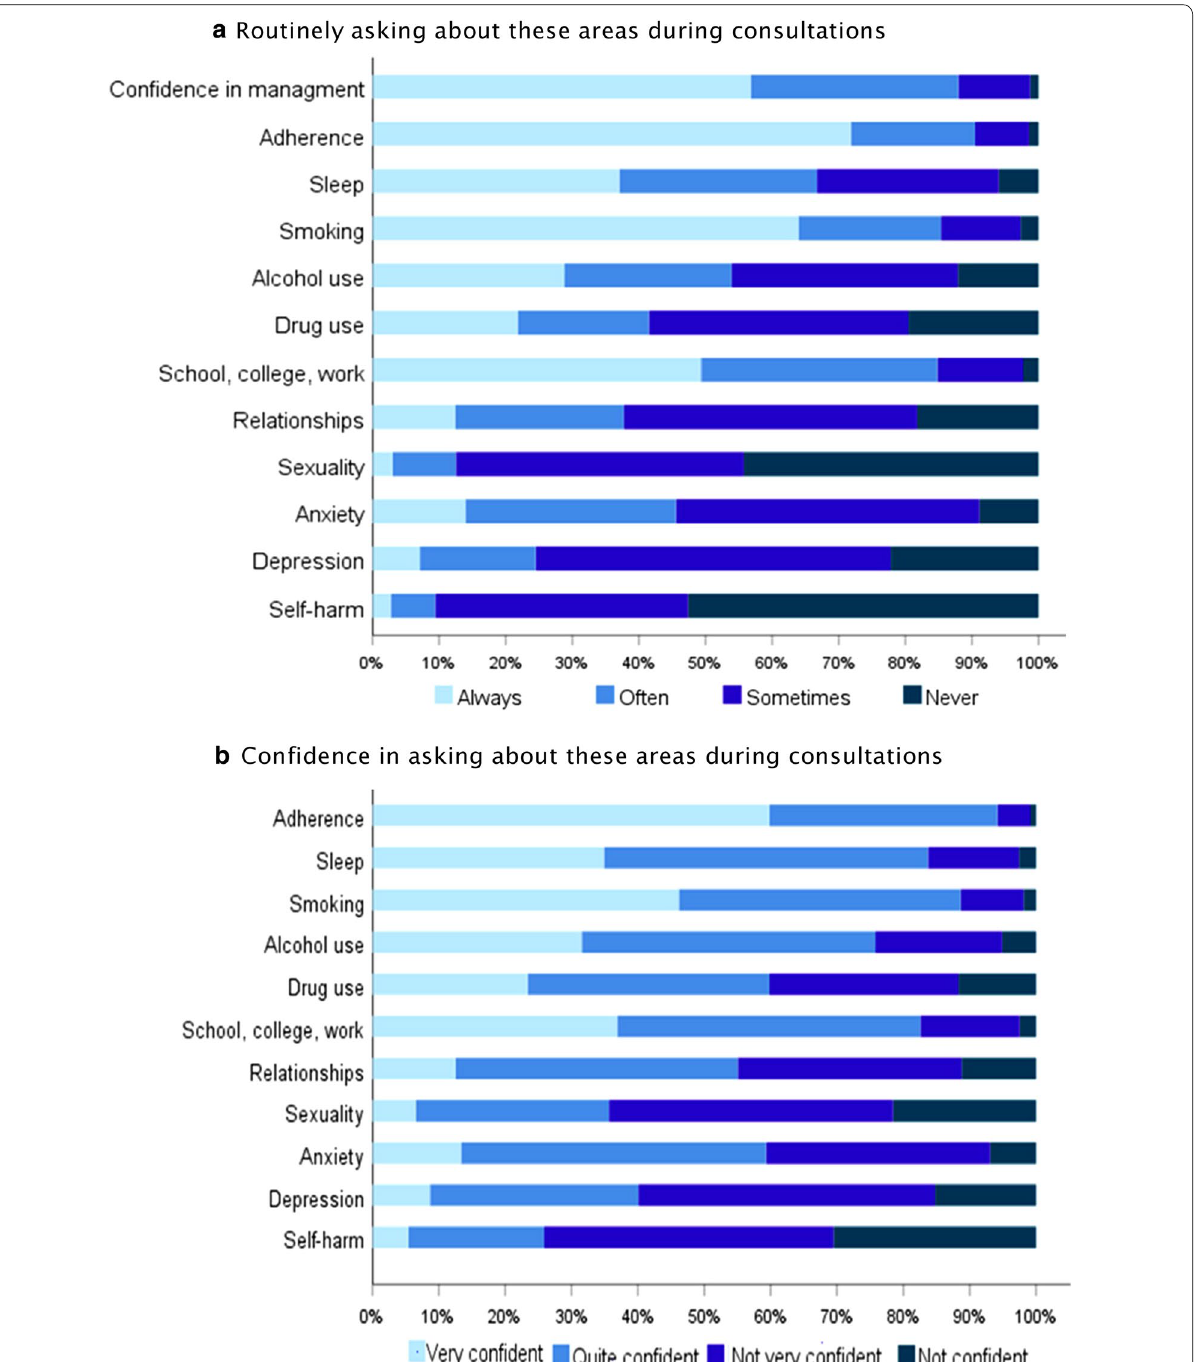
Fig. 2 Challenges for healthcare professionals across Europe when managing adolescents and young adults with allergy and asthma. Results for each based on data from 1179 respondents. Additional file 1: Figure S6 demonstrates that respondents from different clinic types are similarly likely to ask about each